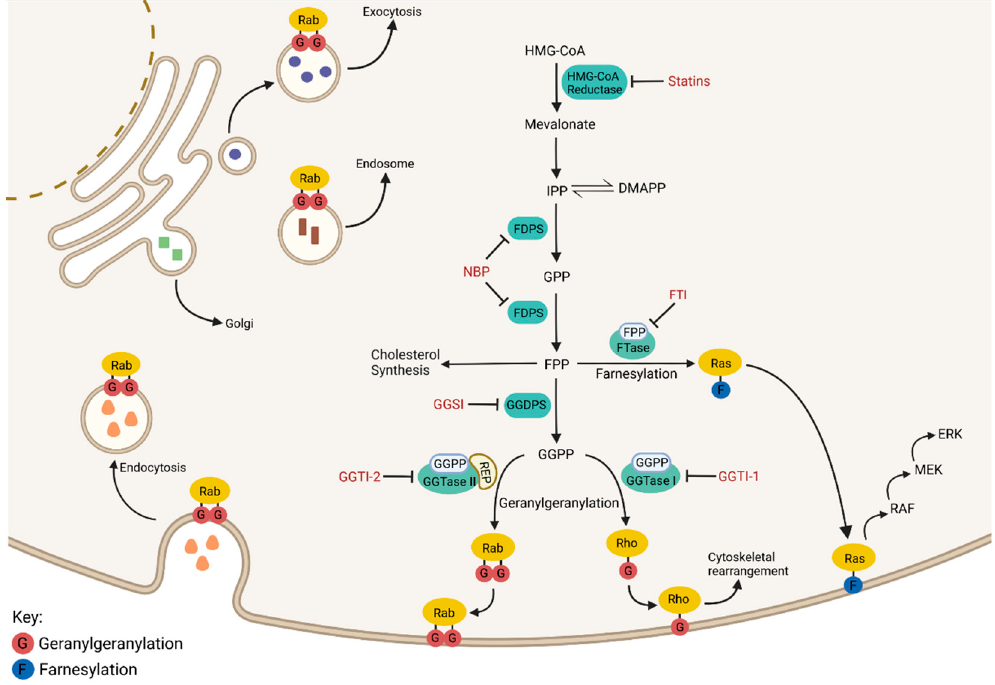
Figure 1. The Isoprenoid Biosynthetic Pathway. An overview of the isoprenoid biosynthetic pathway (IBP) is presented above with inhibitors shown in red and enzymes shown in green. Outcomes of the IBP can be broken down into four categories: (1) cholesterol synthesis, (2) Ras family member farnesylation, (3) Rho family member geranylgeranylation, and (4) Rab family member geranyl- geranylation. Ras, Rho and Rab proteins require prenylation to perform their normal cellular func- tions.